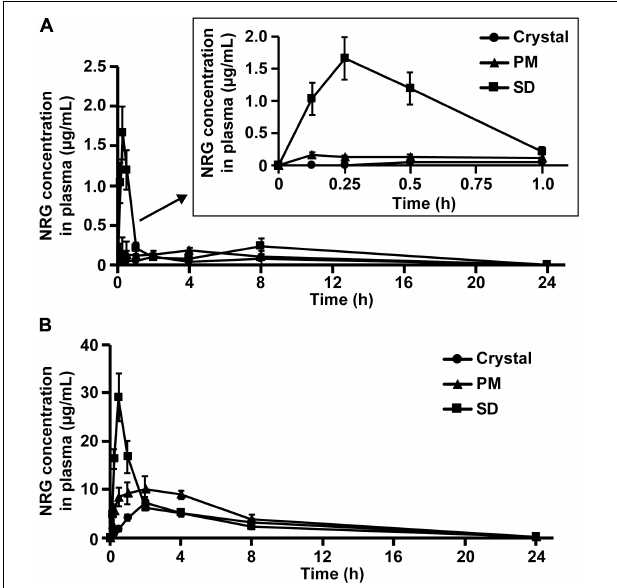
FIGURE 3 | NRG levels in rat plasma after oral administration of NRG SD. Plasma concentrations of unchanged NRG (A) and NRG metabolites (B) after oral administration of crystalline NRG, PM, and NRG SD. NRG equivalent to 100 mg/kg was administered to rats (means ± SE; n = 6).